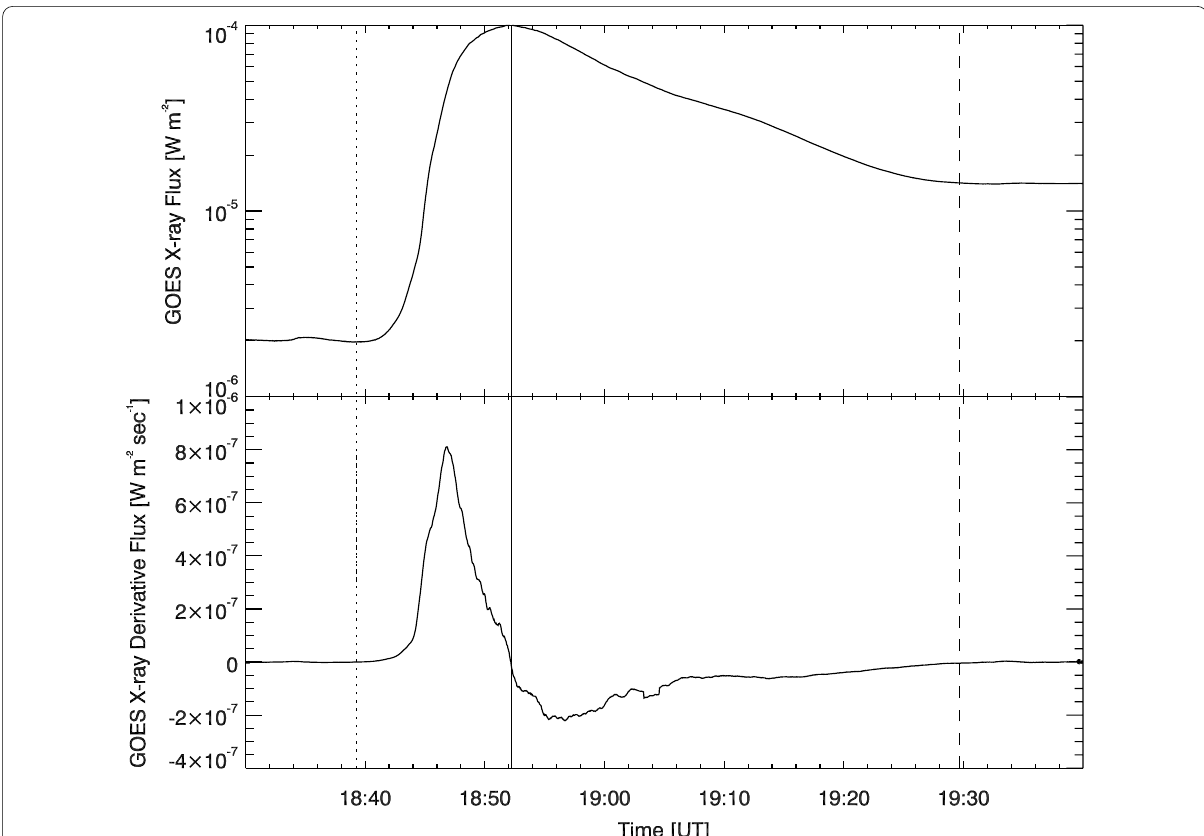
Fig. 1 Example of GOES/XRS-B observation. The light curve of soft X-ray flux (1–8 Å) observed by the GOES/XRS-B for the M9.9-class flare on January 1, 2014 (upper panel). Light curve of soft X-ray time derivative flux (lower panel). The vertical dotted, solid, and dashed lines indicate the flare start time, peak time, and end time,